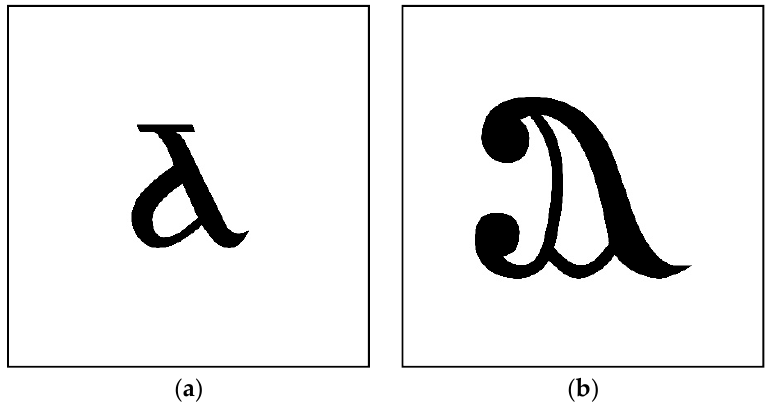
Figure 1. Video frames of the first letter of the Coptic alphabet. ( a ) Lowercase; ( b ) Uppercase.